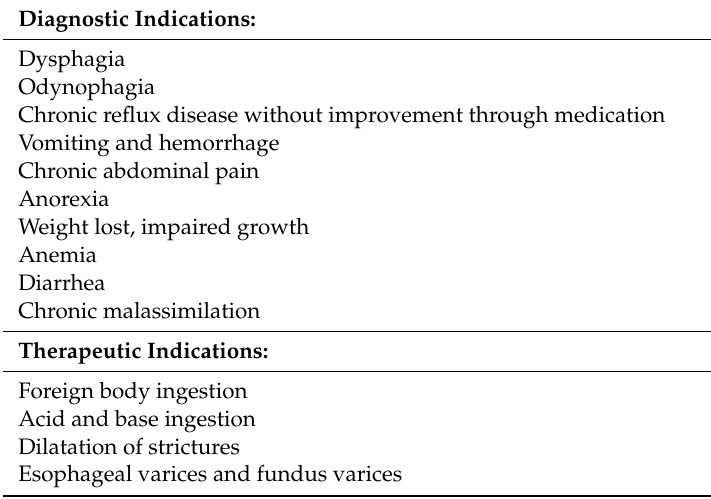
Table 2. Indications for endoscopy in the upper gastrointestinal (GI)